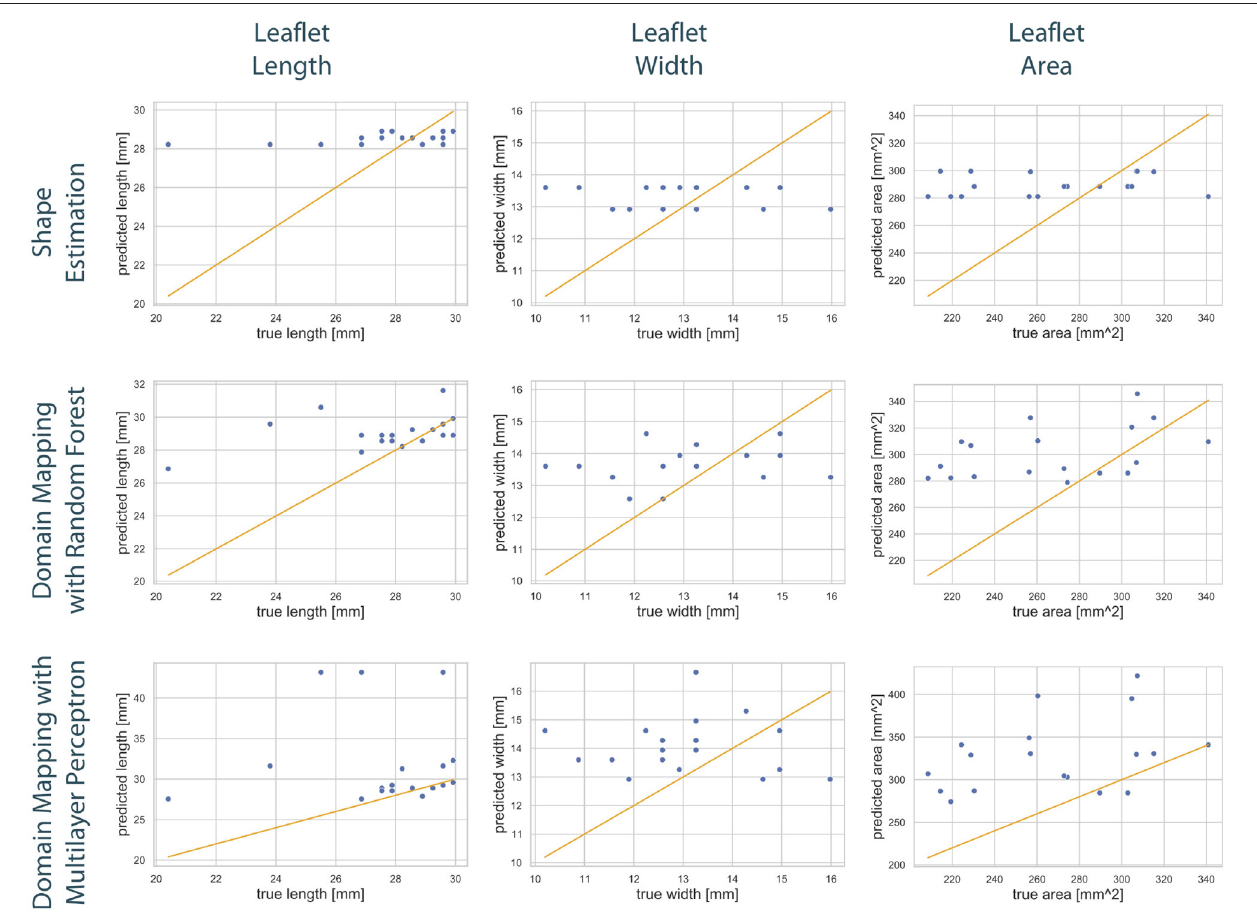
FIGURE 9 | Correlation between geometric features of the predicted leaflets and the corresponding ground truth. The columns show the predicted length (left) , width (middle) , and area (right) in dependency of the true one, respectively. The assessed data points from the test set of one fold (blue) are scattered around the line sketching optimal correlation (orange). The rows correspond to the utilized prediction model, i.e., shape estimation (top) , domain mapping with RF (middle) , and domain mapping with MLP (bottom) . While shape estimation only predicts a limited number of possible outputs, both domain mapping approaches approximate the leaflet length sufficiently, with some severe outliers in the MLP-based approach. Both methods tend to overestimate the leaflet size. Please not the different scaling of the